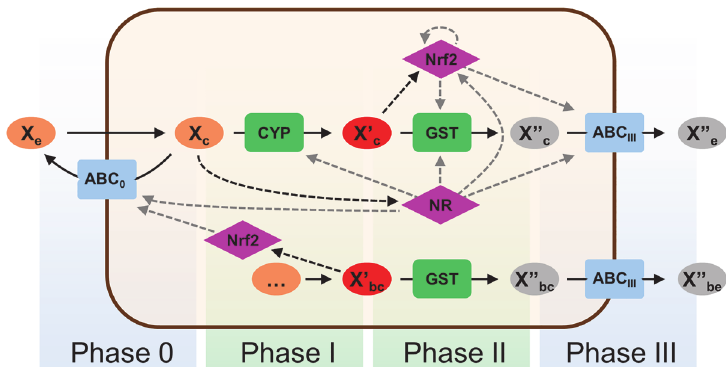
Fig 1. Simplified wiring diagram of the chemoimmune network model. Modeled interactions of a single xenobiotic (X) with Phase 0-III effector enzymes and regulators. Solid arrows represent transport through membranes or biochemical reactions. Dashed arrows denote regulation including multi-step transcriptional and translational regulation (gray) and more direct interaction (black), such as binding of a drug to nuclear receptors. ABC 0 and ABC III symbolize general Phase 0 and Phase III efflux transporters, respectively. CYP and GST represent a Phase I oxidase (a member of the cytochrome P450 superfamily) and a Phase II GSH transferase, respectively. NR symbolizes a general xenobiotic nuclear receptor, while Nrf2 denotes a specific transcription factor. (GST, ABC III and Nrf2 are duplicated to increase clarity of the figure. Regulatory arrows are not duplicated.) Letters ‘ c ’ and ‘ e ’ indicate cytoplasmic and extracellular localization, respectively. X ’ c is the CYP-oxidized cytoplasmic metabolite of X c . X ” c is the glutathione-conjugated form of X ’ c . X ’ bc represents reactive species produced by normal cell metabolism. X ’ bc is metabolized by the same pathway as X ’ c . Negative feedback loops are X c ! NR ! CYP — | X c , X ’ c (and X ’ bc ) ! Nrf2 ! GST — | X ’ c (and X ’ bc ), X c